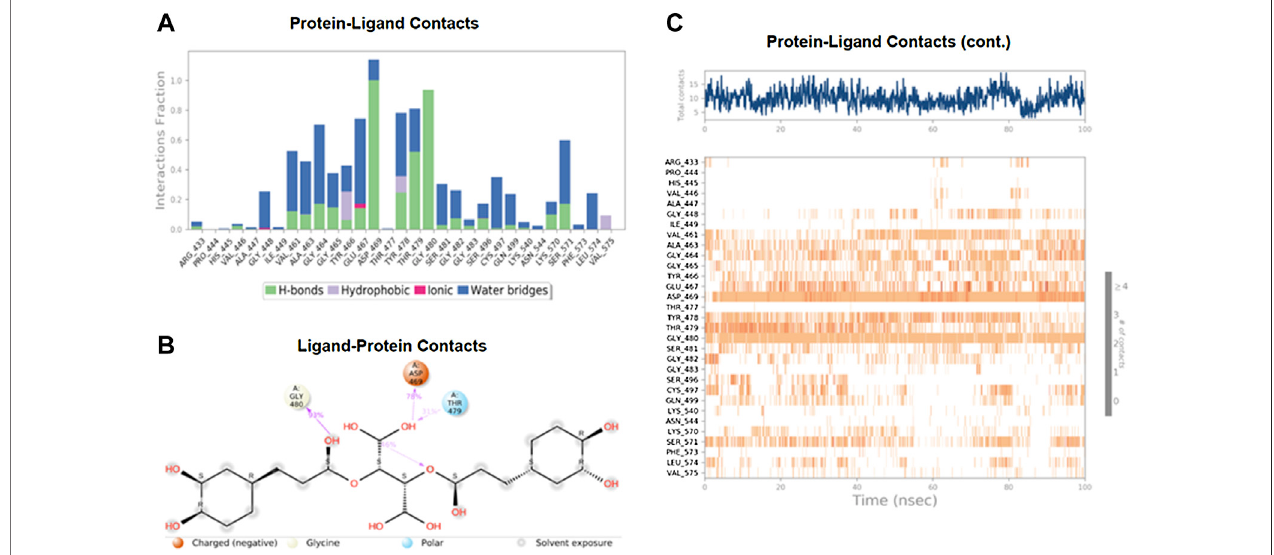
FIGURE6| TheinteractionanalysisofchicoricacidwithUHRF1. (A) UHRF1interactionswithChicoricacidthroughoutthesimulation.Theinteractionsbetweenthe ligand and protein were classi fi ed into hydrophobic, ionic, hydrogen bonds, and water bridges. Each classi fi cation can be further sub-grouped and noticed in the “ Simulation Interactions Diagram ” panel. The stacked bar charts were normalized over the trajectory ’ s course: for example, a value of 0.7 suggested that the speci fi c interaction was maintained 70% of the simulation time. Values over 1.0 were possible, as some protein residue may make multiple contacts of the same subtype withtheligand. (B) TheschematicdiagramshowedthedetailedatomicinteractionofChicoricacidwithUHRF1.Interactionsoccurredmorethan30.0%ofthesimulation time in the selected trajectory (0.00 through 100.00 ns). It is possible to have interactions with > 100% as some residues may have multiple interactions of a single type withthesame ligand atom. (C) Atimeline representation ofUHRF1- Chicoric acidinteractionsispresented in (A) .The toppanel showed thenumber ofspeci fi ccontacts thattheproteinmadewiththeligandthroughoutthetrajectory.Thebottompanelshowedwhichresiduesinteractedwiththeligandineachtrajectoryframe.Accordingto the scale of the plot, some residues made more than one speci fi c contact with the ligand, which was represented by a darker shade of orange.